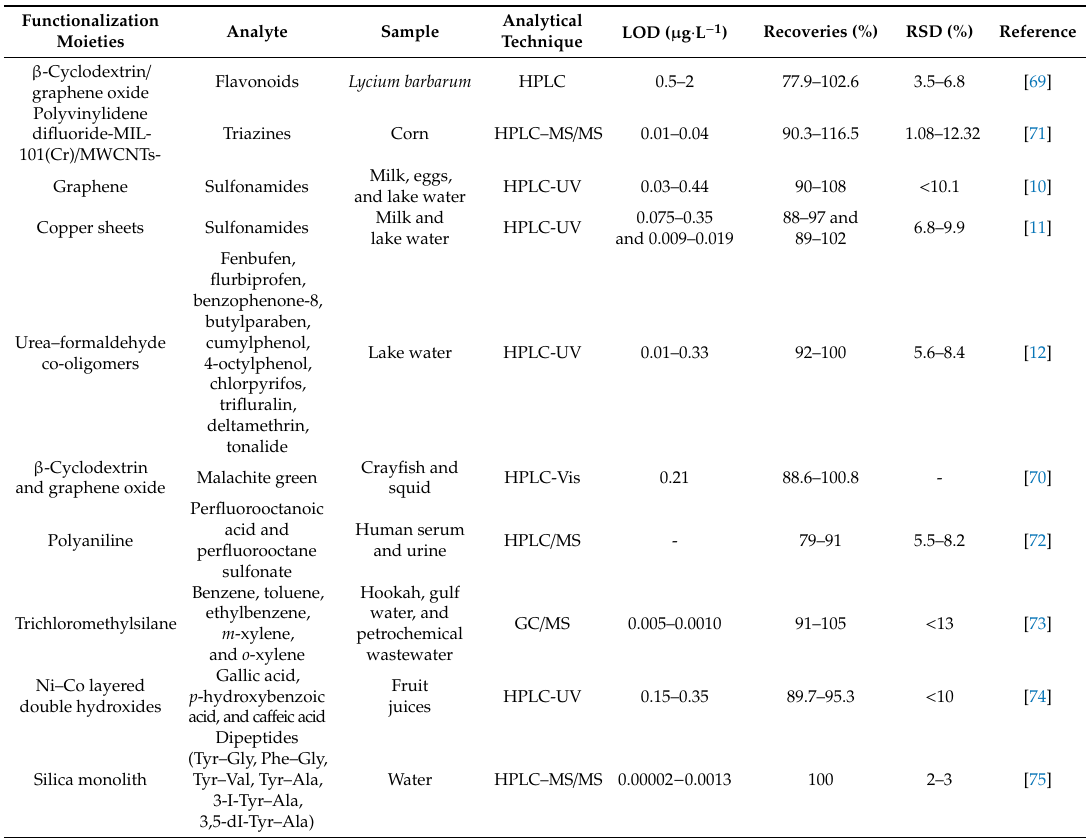
Table 5. Analytical methods developed based on melamine sponges. MWCNT: multi-walled carbon